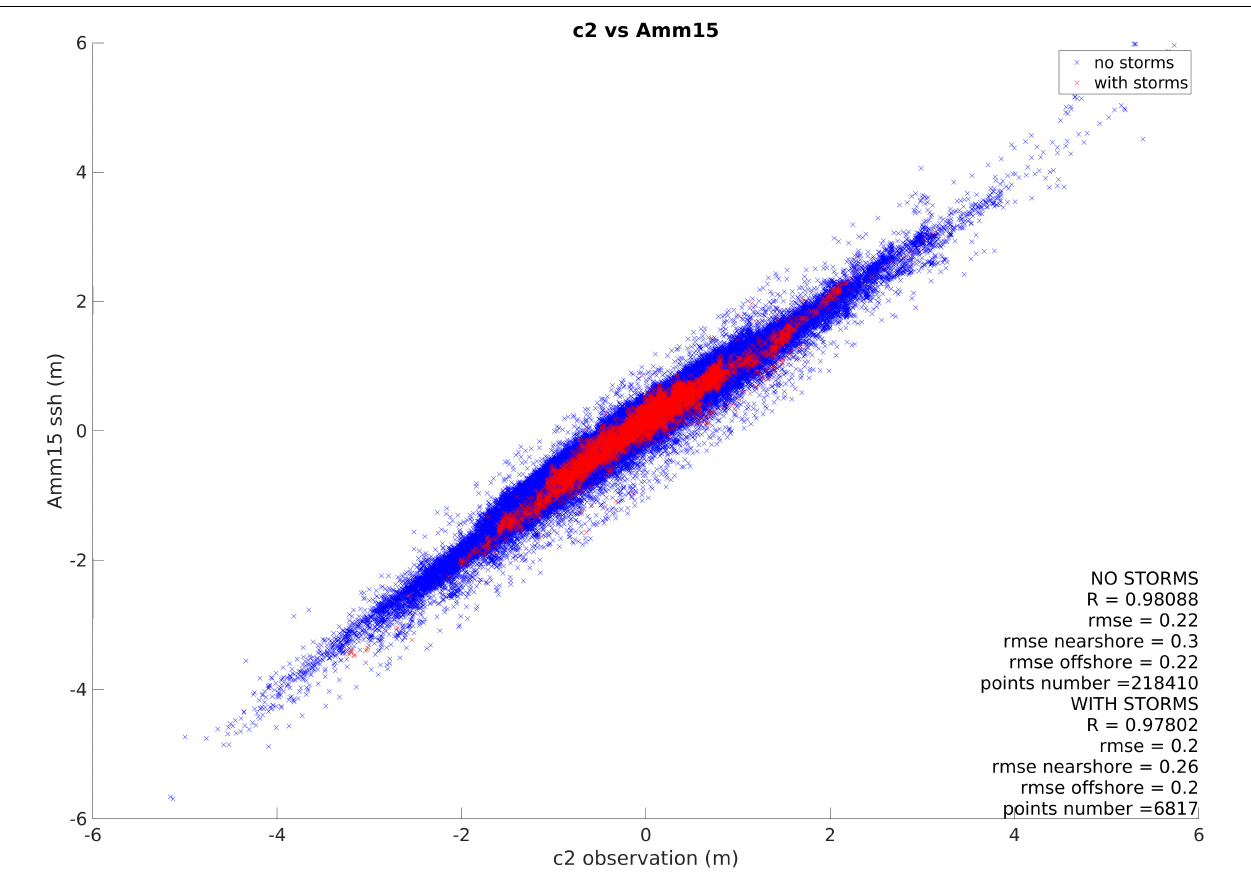
FIGURE 6 | Correlation between C2 and Amm15 during period with and without storms. The plot also shows the statistics calculated from values closer than 10 km from the coast (near shore) or further than 50 km from the coast (offshore).